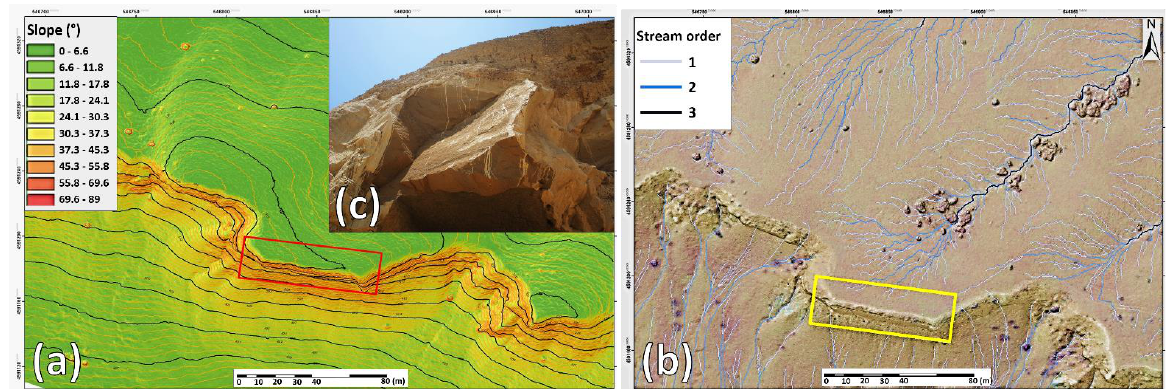
Figure 14. UAV-DP high resolution DEM derived products: slope map ( a ) (the monastery complex is located by the red rectangle); drainage pattern map ( b ) (the monastery complex is located by the yellow rectangle); UAV close-up on the detachment sector showing light brown colored mud drips on the dark brown sandstones ( c ).